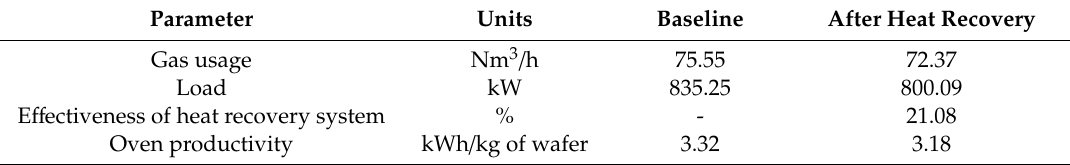
Table 14. Key performance indicators of the industrial-scale baking oven before and after heat recovery.